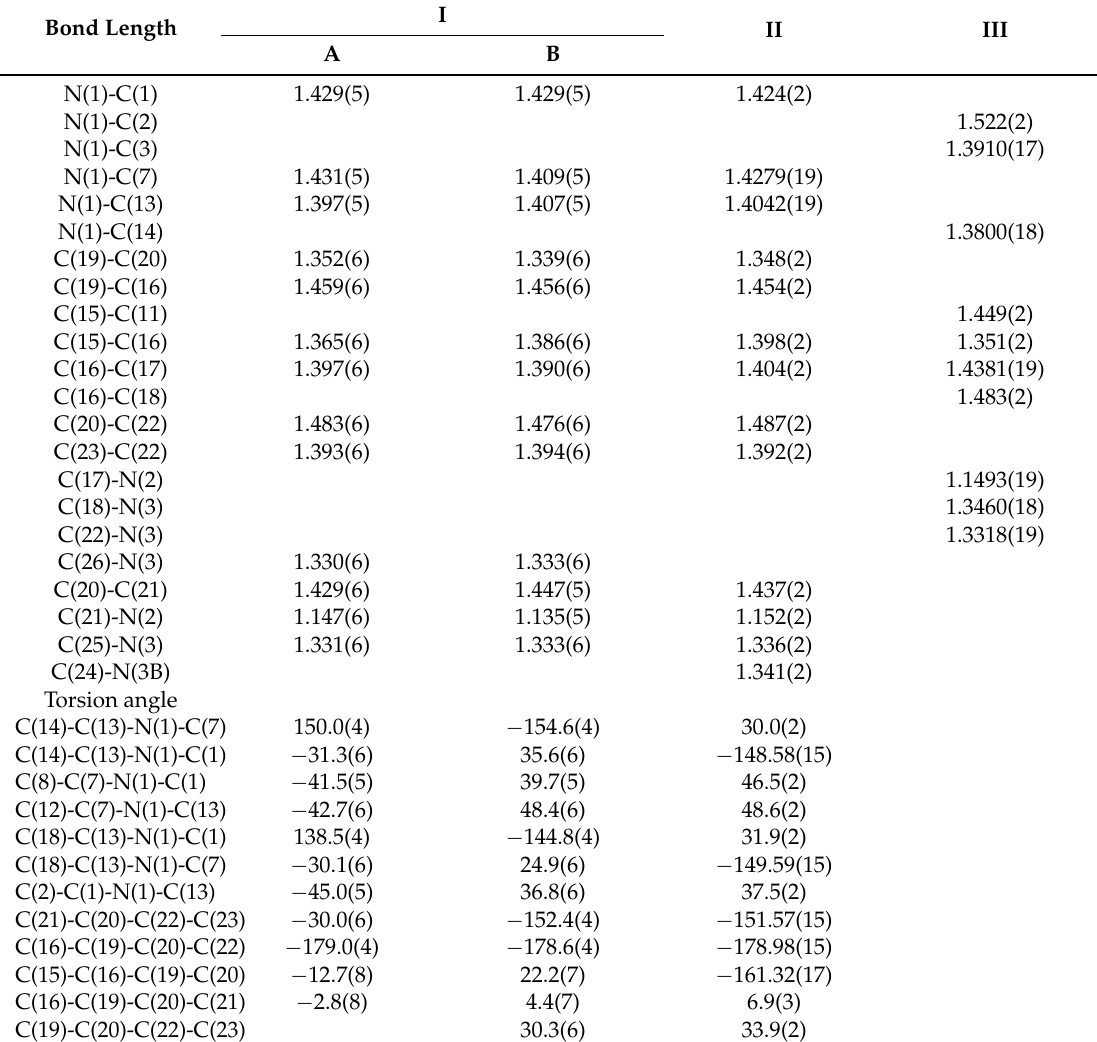
Table 3. Bond lengths (Å) and torsion angles ( ˝ ) selected in the crystal structures of I and II